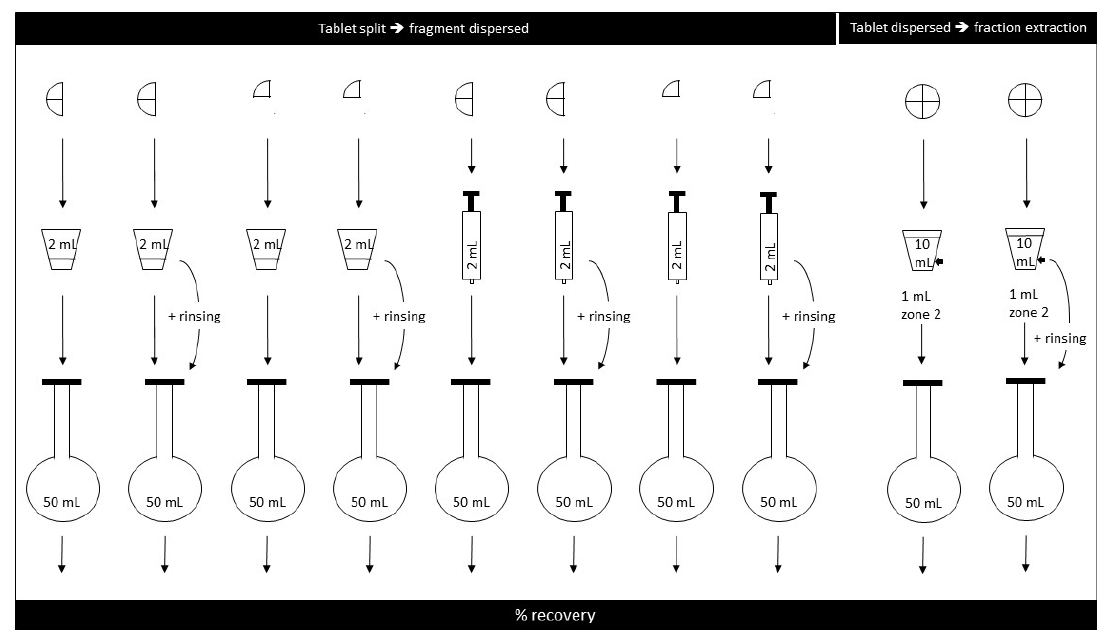
Figure 1. Illustration of tablet manipulations performed to obtain child-adjusted doses (n = 6).